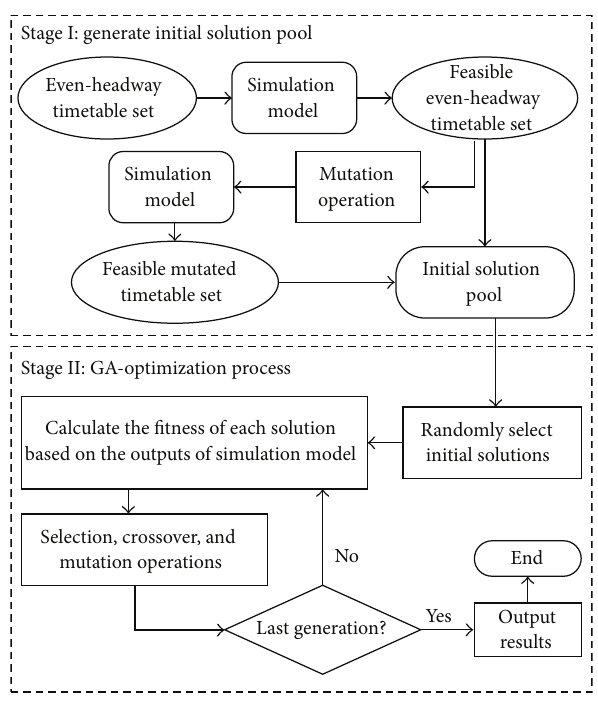
Figure 9: Optimization procedure integrating simulation and GA.